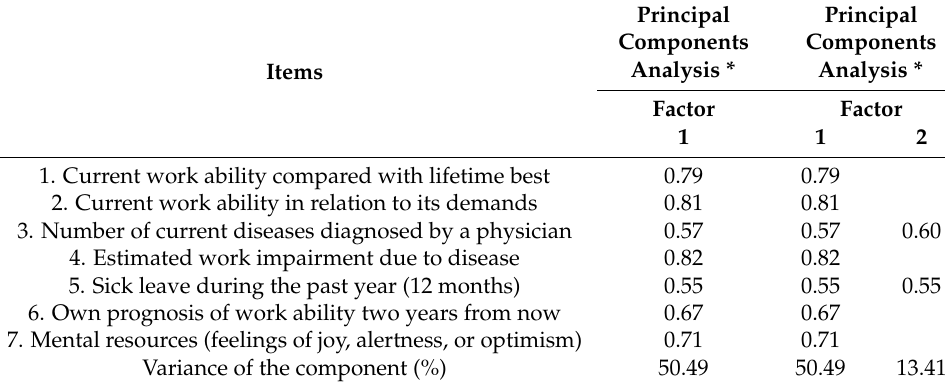
Table 2. Exploratory factor analysis of the Spanish version of the work ability index administered to health sector